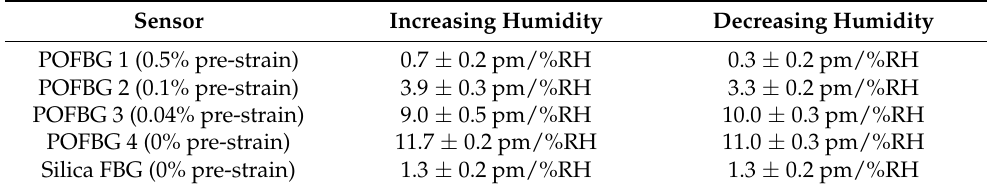
Figure 14. Relative humidity response of the 4 POFBG array and silica grating sensors under different pre-strain values with ( a ) increasing humidity, and ( b ) decreasing humidity. Table 3. Humidity sensitivities of sensors.